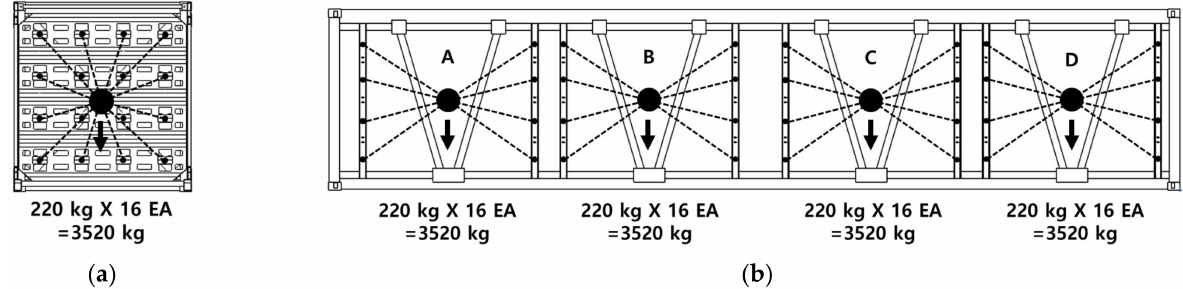
Figure 5. Hydrogen tube weight condition using equivalent load. ( a ) Front view; ( b ) side view.